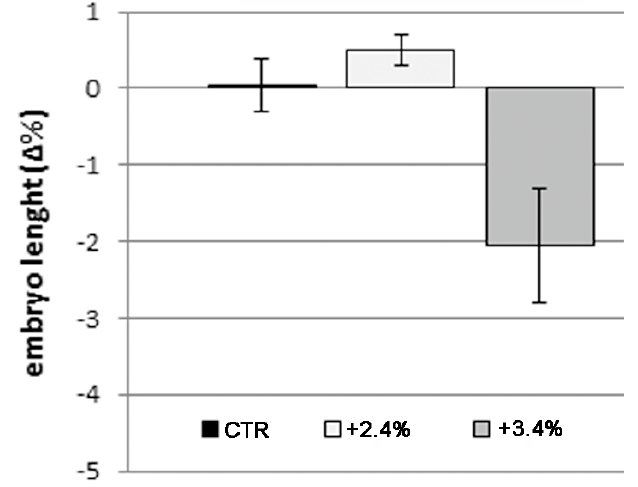
Figure 3. Difference of length ( ∆ %) in 5 dpf embryos grown under different increases in HP from 0% (CTR) up to 3.4%. Embryos grown under +3.4% HP show a statistically non-significant reduction in body length (CTR vs. +3.4%, -2%).